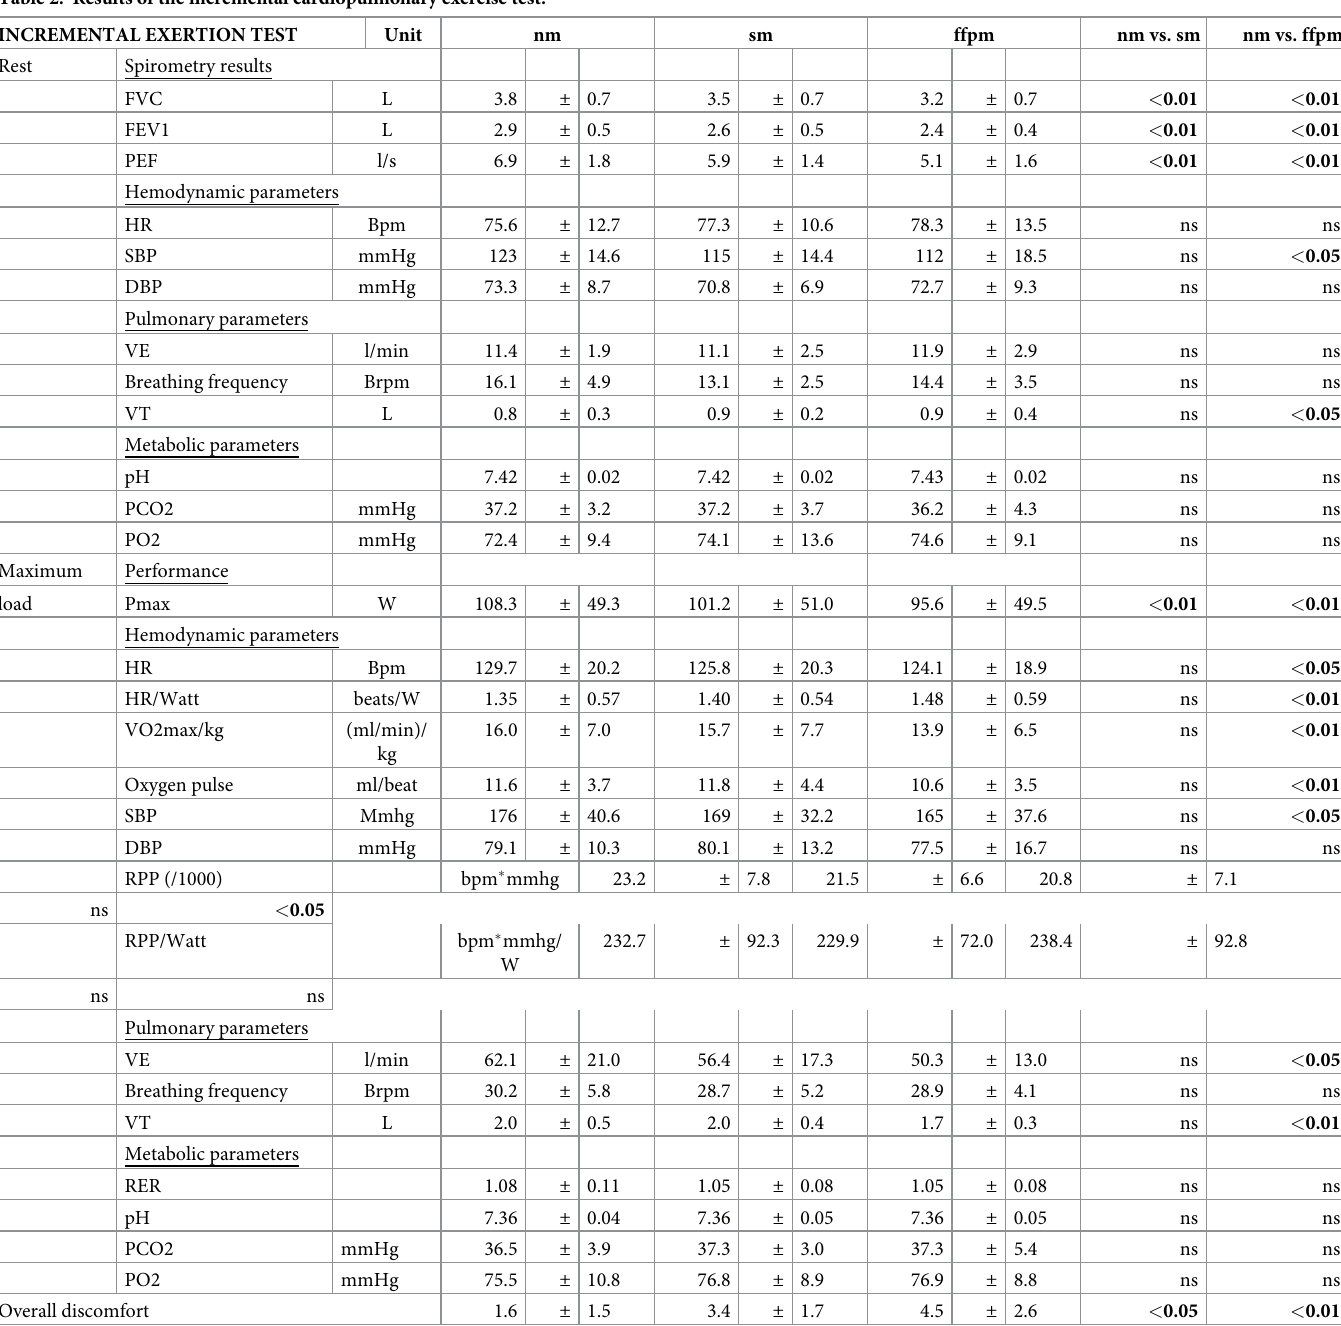
Table 2. Results of the incremental cardiopulmonary exercise test. INCREMENTAL EXERTION